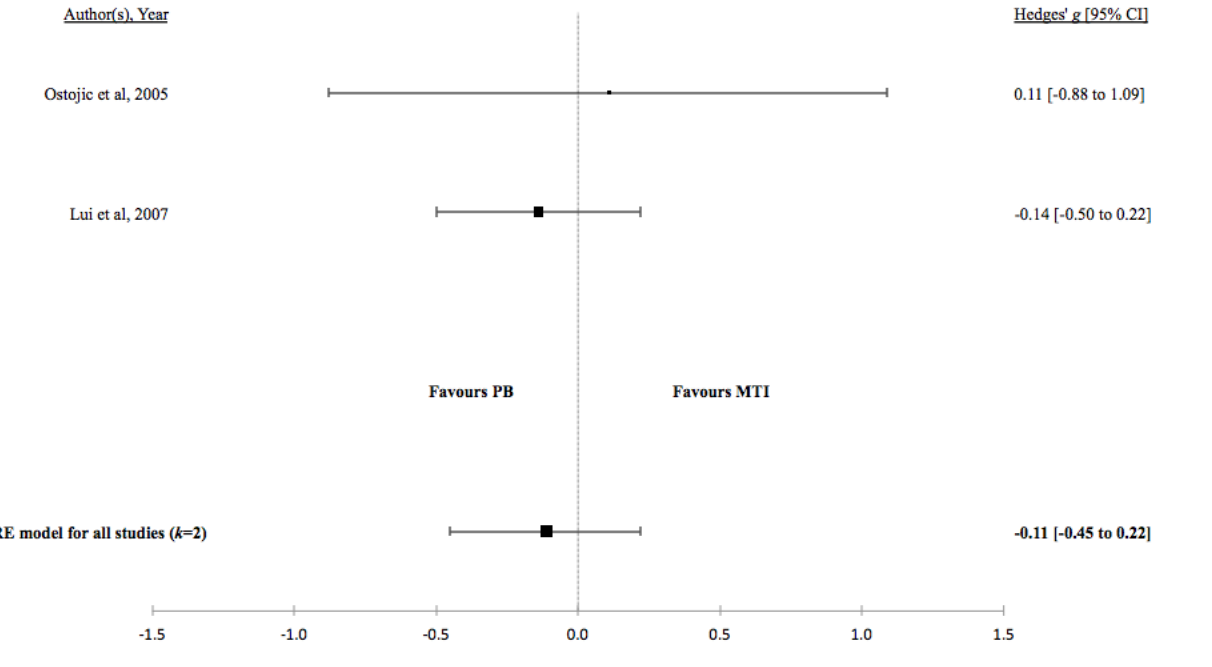
Figure 5. Forest plot of the standardized mean difference in symptom or diary adherence between MTI and paper-based group (PB). MTI: mobile technology intervention.